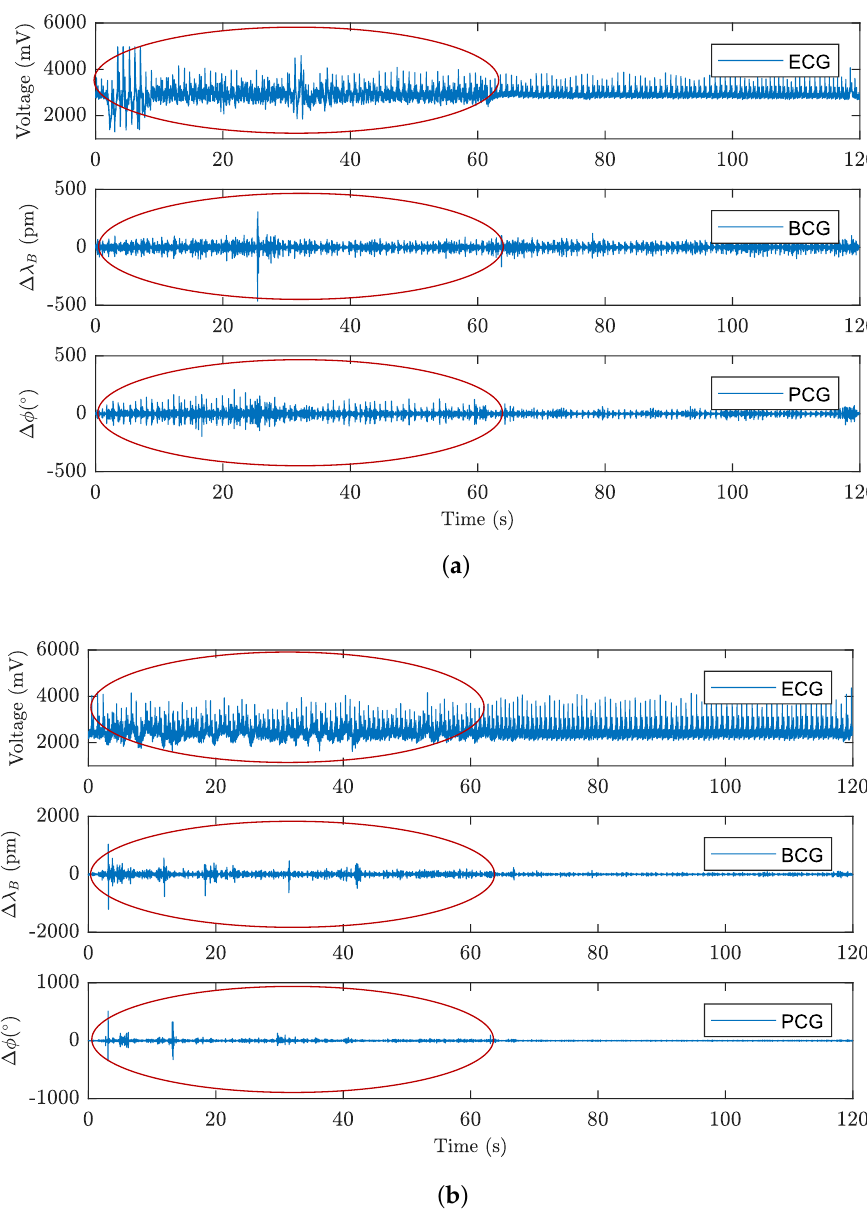
Figure 17. ( a ) an example of the impact of minor effects on the signal measured; ( b ) an example of the impact of major effects on the signal